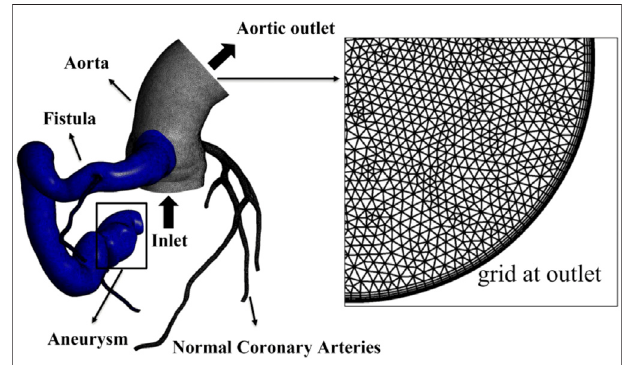
FIGURE2| Computationaldomainandmeshofcase2,withlocalgridat theaorticoutletshowing fi veboundarylayers.The fi stularegionisindicatedby blue part.